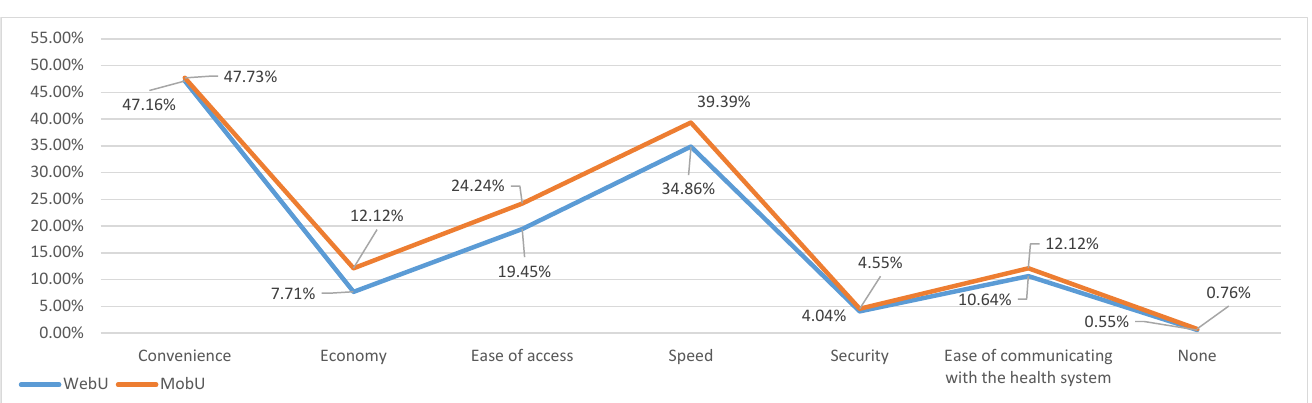
Table 5. Actions that could improve the impact of ICTs on health services (by user profile).